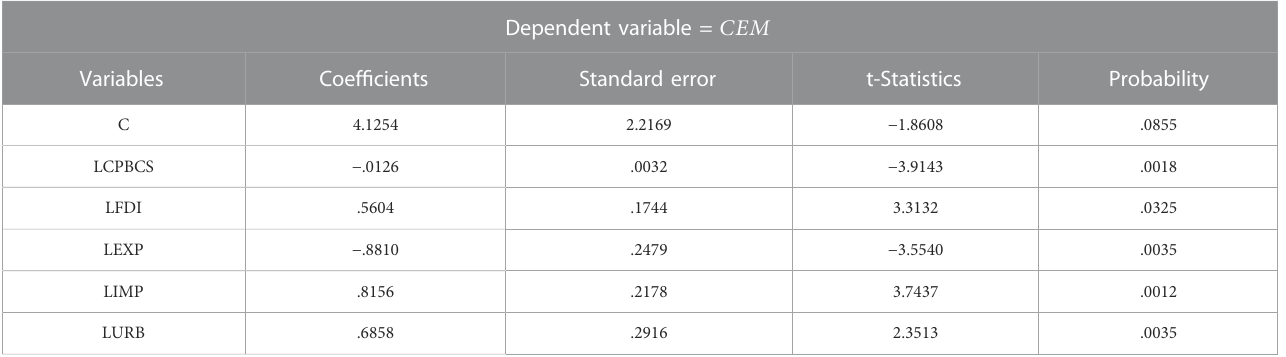
TABLE 5 ARDL long-run Coef fi